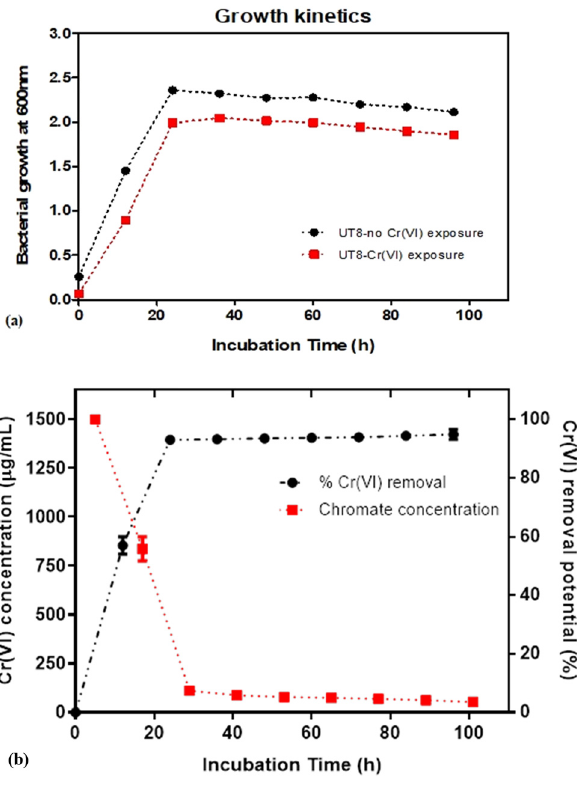
Figure 2: Chromium ( VI )- tolerant bacterium UT8 ( a ) growth kinetics and ( b ) chromate removal and residual investigation.